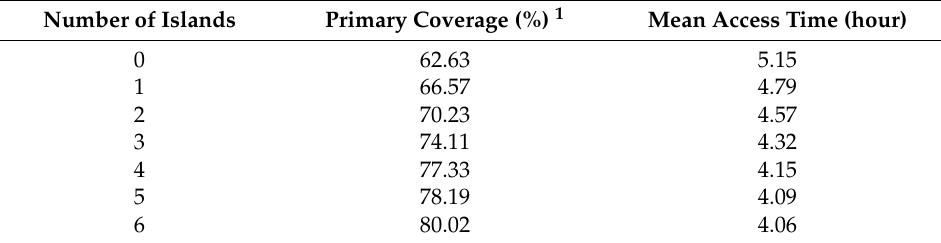
Table 3. Comparison of the maximum coverage